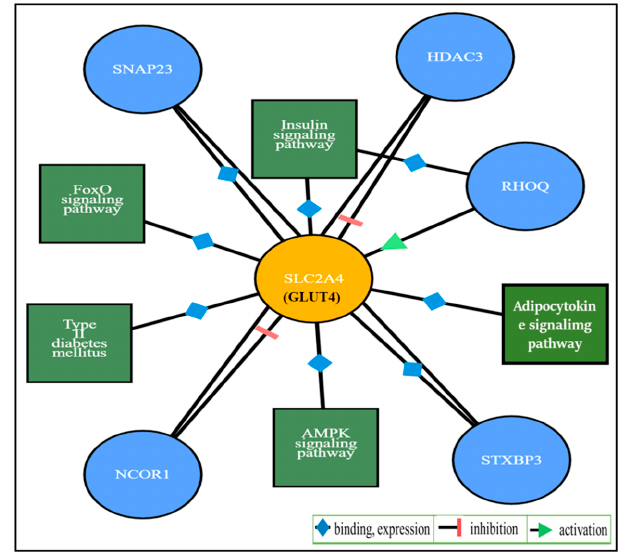
Figure 2. Illustration of interacting pathways and genes with SLC2A4 (GLUT4).